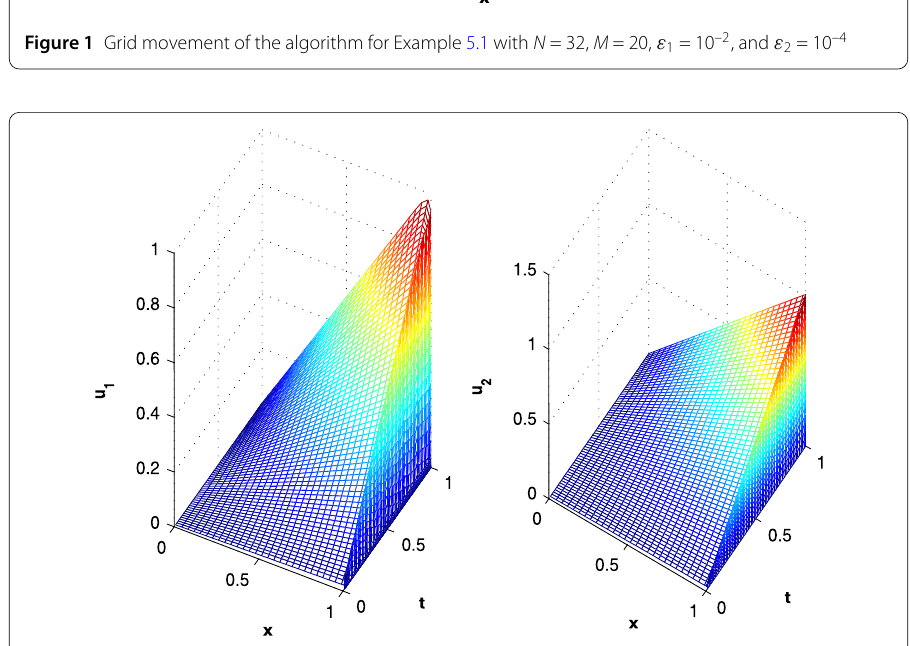
Figure 2 Numerical solution of Example 5.1 for N = M = 64, ε 1 = 10 –4 , and ε 2 = 10